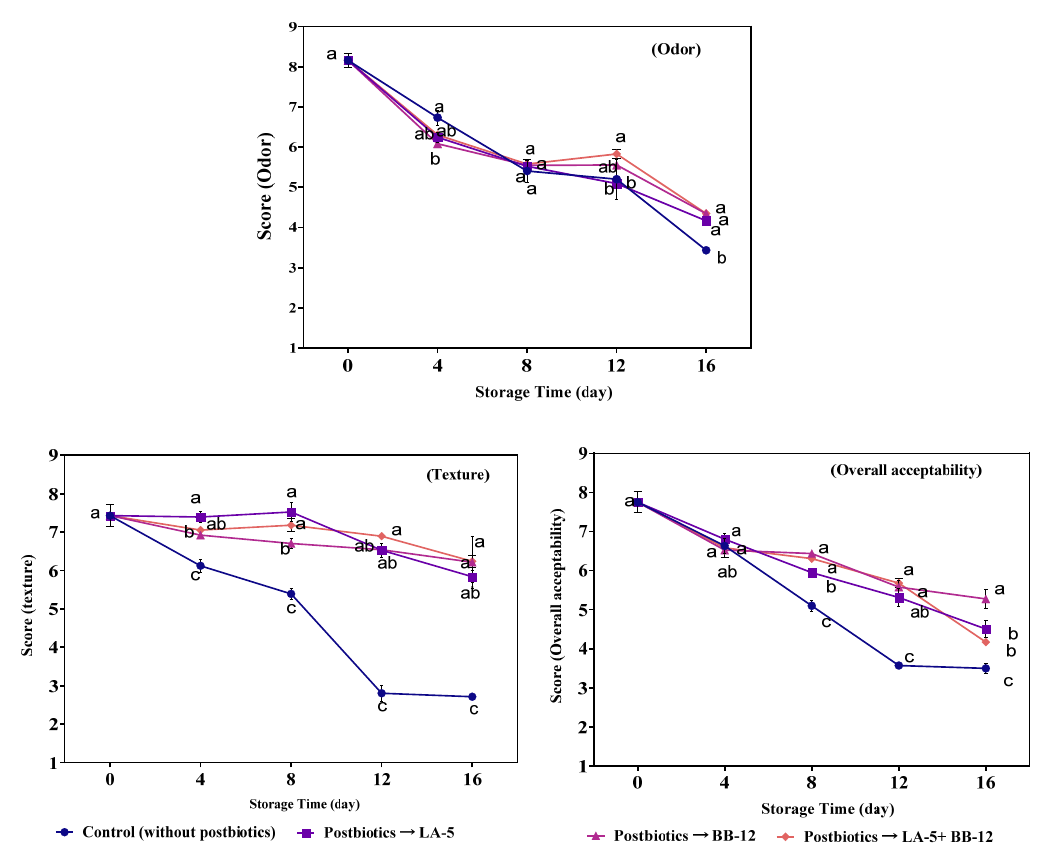
Figure 4. Sensory scores (odor, texture, and overall acceptability) in mozzarella cheese preserved in postbiotic solutions from L. acidophilus LA-5 (P-LA-5), B. animalis BB-12 (P-BB-12), and their combination during 16 days of storage. Different lowercase letters indicate a significant ( p < 0.05) difference between treatments on each storage day.